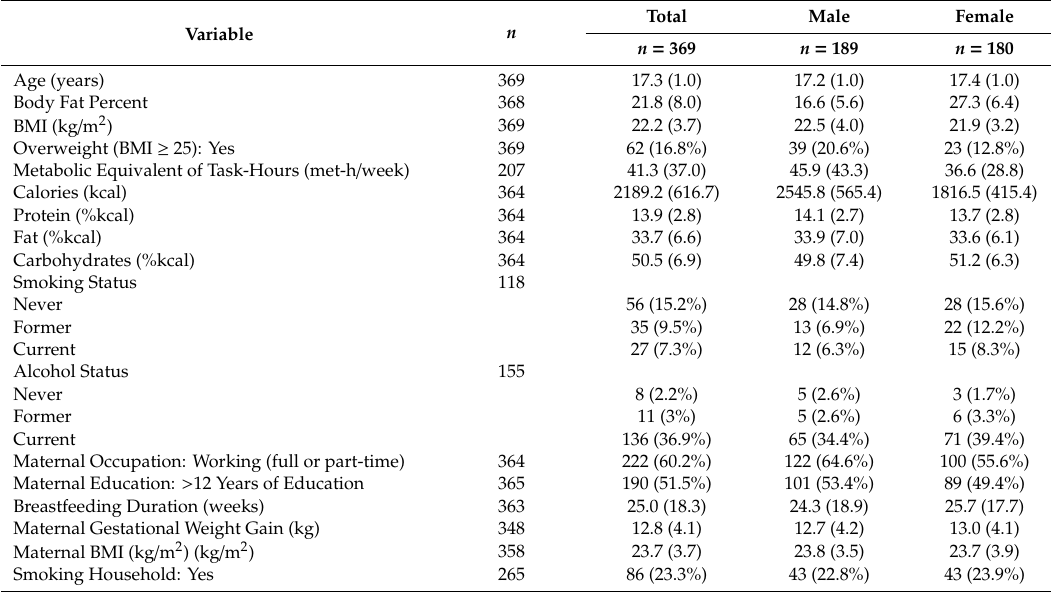
Table 1. Characteristics of 369 Dortmund Nutritional and Anthropometric Longitudinally Designed (DONALD) study participants aged 16 to 18